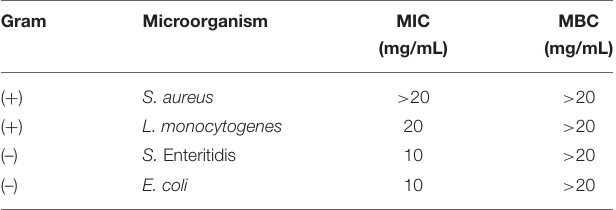
TABLE 4 | Minimal inhibitory concentration (MIC) and minimal bactericidal concentrations (MBC) of extracts obtained from Red eggplant against